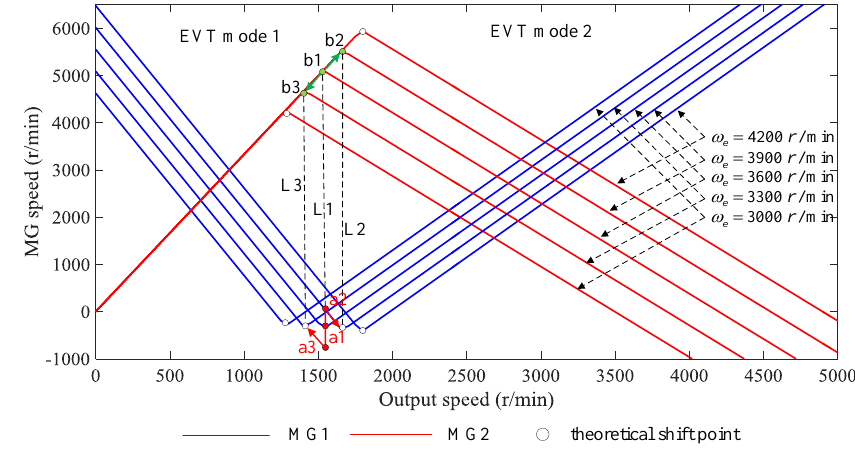
Figure 6. Analysis of theoretical shift point.